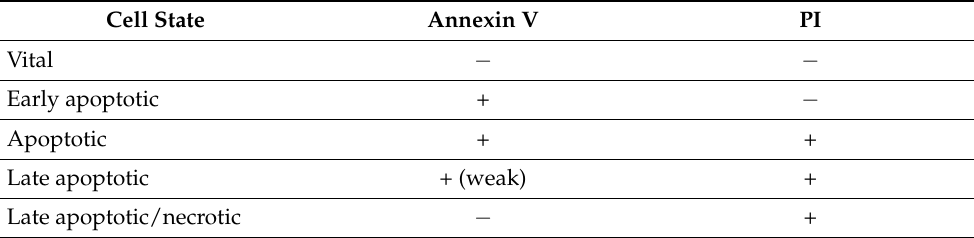
Table 6. Modified characteristics of fluorescence signals for apoptosis classification of PMNs using fluorescence